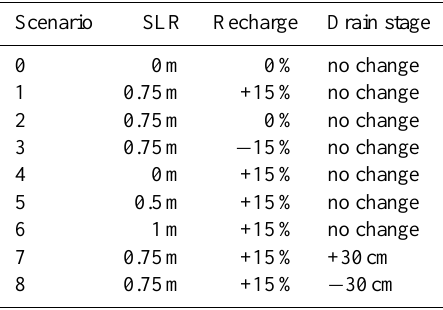
Table 2. Climate change